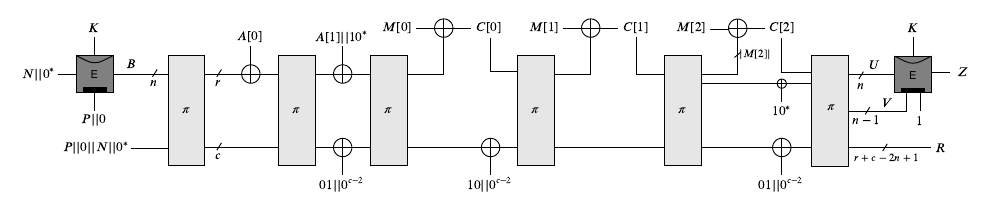
Figure 9: Spook v2 mode (switching P || 0 || N || 0 ∗ and B in the first Shadow-512 call).